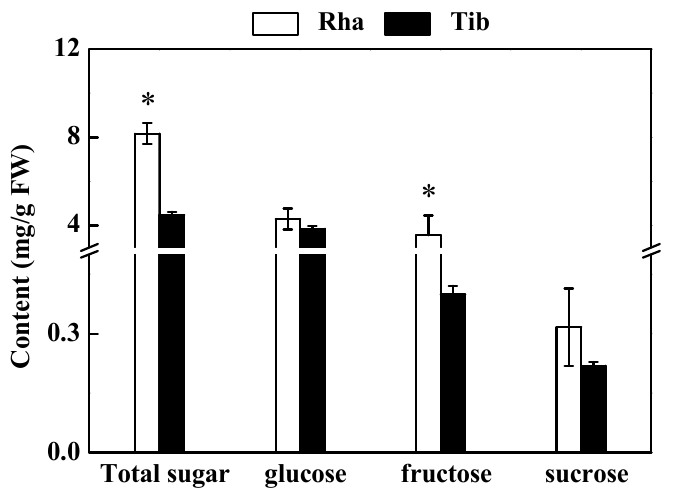
Figure 1. The content of soluble sugars in Rha and Tib berries. Vertical bars represent standard error of the mean ( ± SE), and the “*” indicate significant differences at p < 0.05. Compared with Tib, Rha had a higher total acid and quinic acid content, but lower tartaric acid and citric acid content. There was no significant difference between the two sea buckthorn berries in terms of malic acid and succinic acid (Figure 2). Quinic acid and malic acid were the main organic acids, accounting for over 90% of the total acid